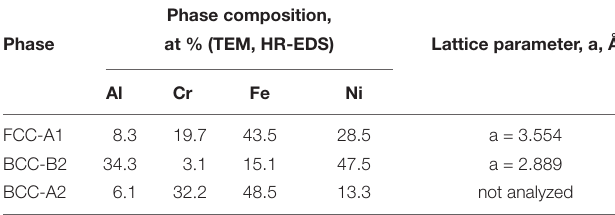
Frontiers in Materials |